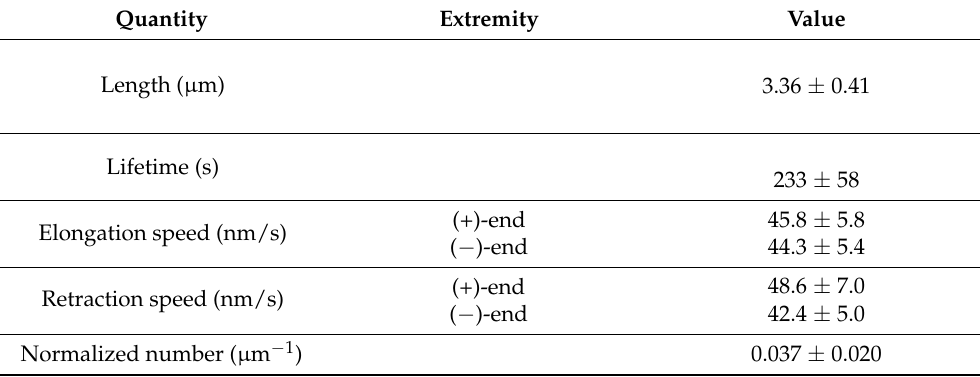
Table 1. Filopodia characteristics in the microstructures. Values extracted from timelapse movies ( n = 15, error: